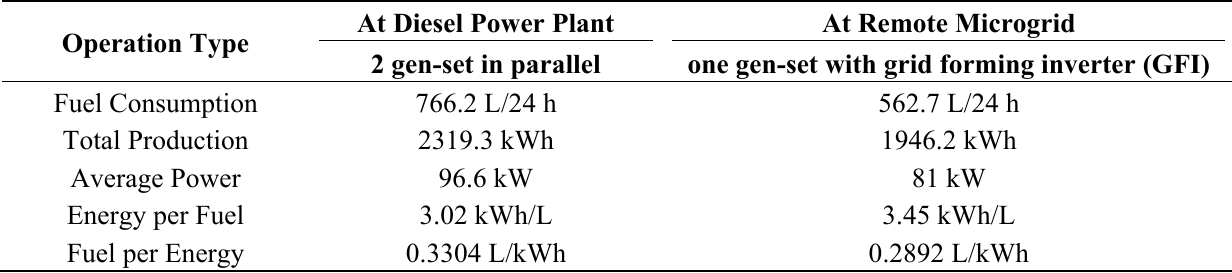
Table 9. Fuel consumption comparison of a diesel